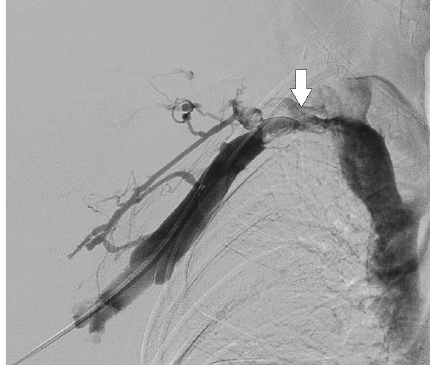
Figure 5: Peripheral angiogram showing residual stenosis at the level of clavicle (arrow) after performing thrombectomy and angio-